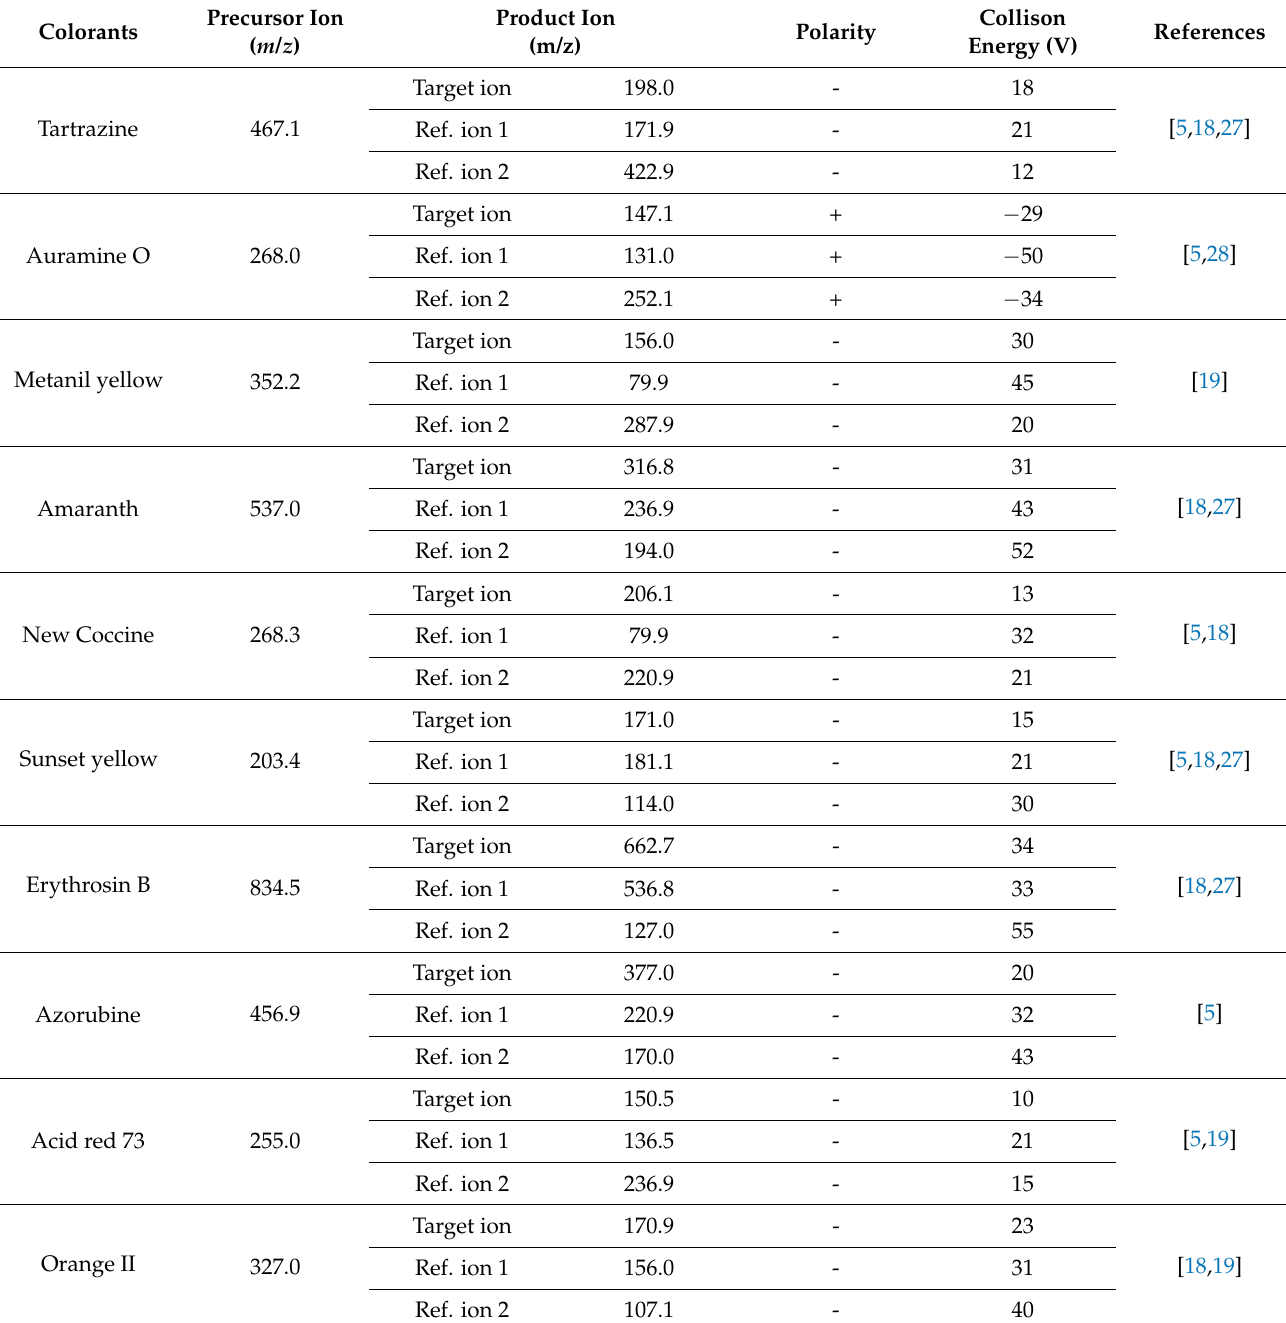
Table 4. MRM conditions of the LC-MS/MS to identify ten synthetic dyes in herbal